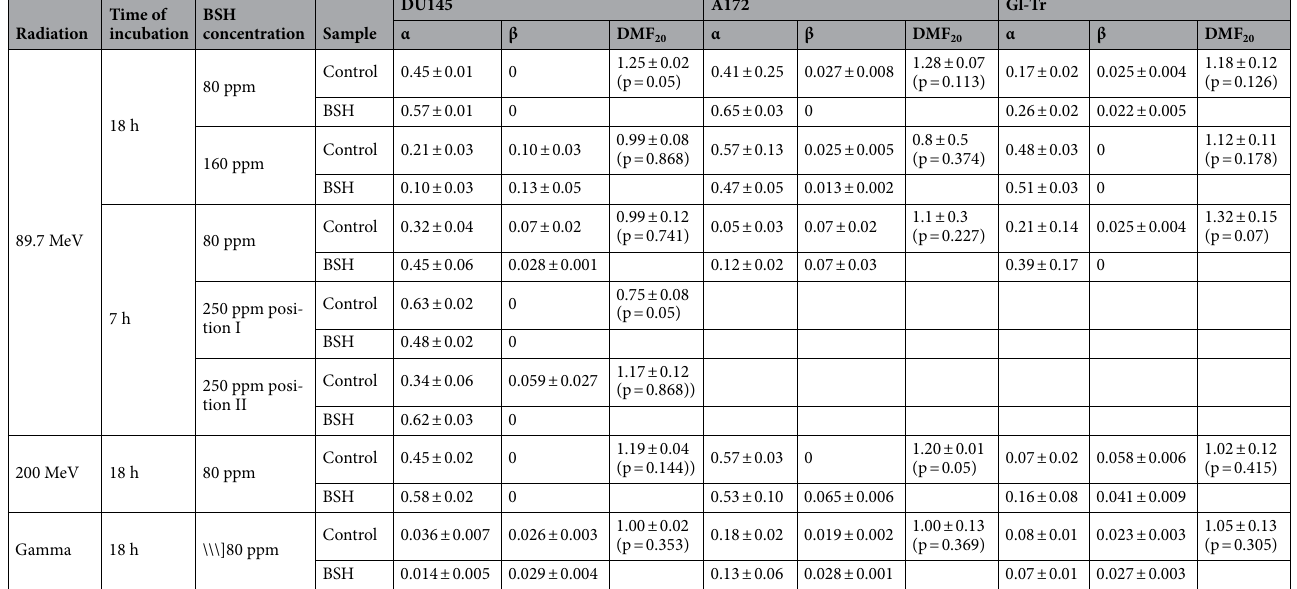
Table 2. Parameters for the linear-quadratic fit of clonogenic survival data Y(X) = exp (–αX–βX 2 ), and dose- modifying factor for 20% survival (DMF 20 ) of Du145, A172, and Gl-Tr cells with proton irradiation alone (Control) or after incubation with boron-11